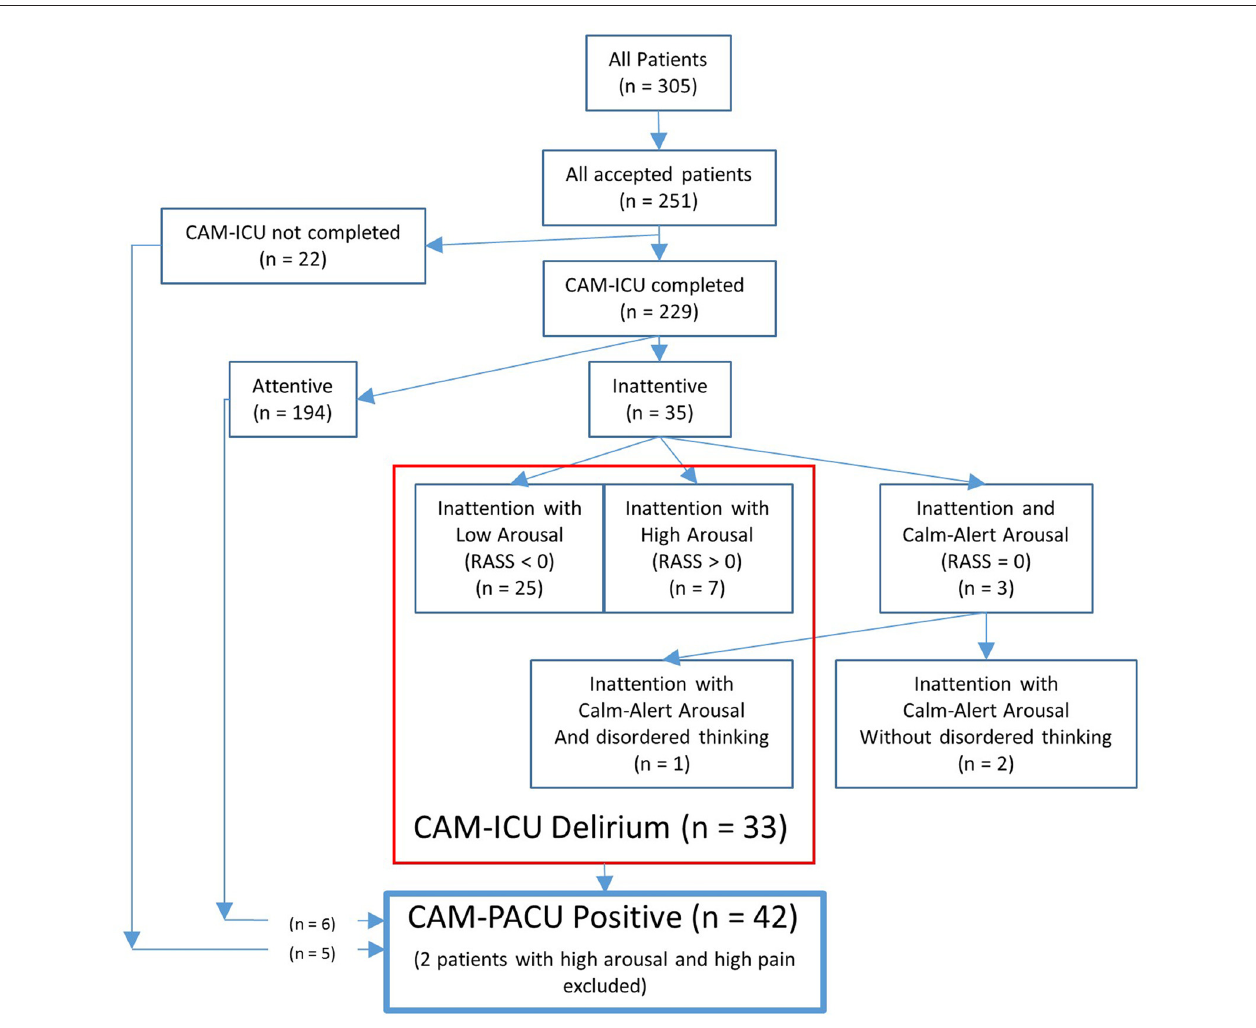
FIGURE 1 | Flow-chart showing the number of patients diagnosed with delirium according to the confusion assessment method-intensive care unit (CAM-ICU), or who were confusion assessment method-post anesthesia care unit (CAM-PACU)